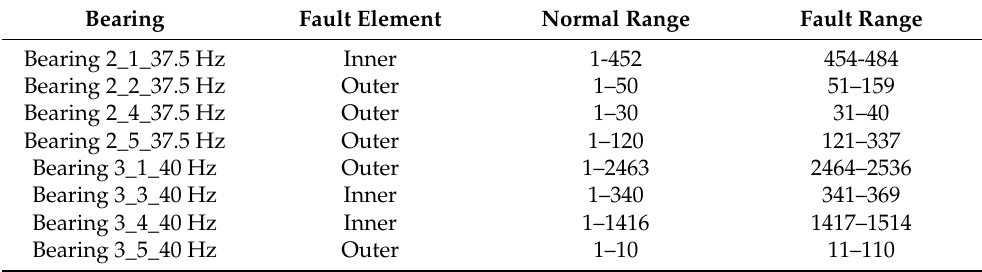
Table 4. Bearings selected from XJTU-SY